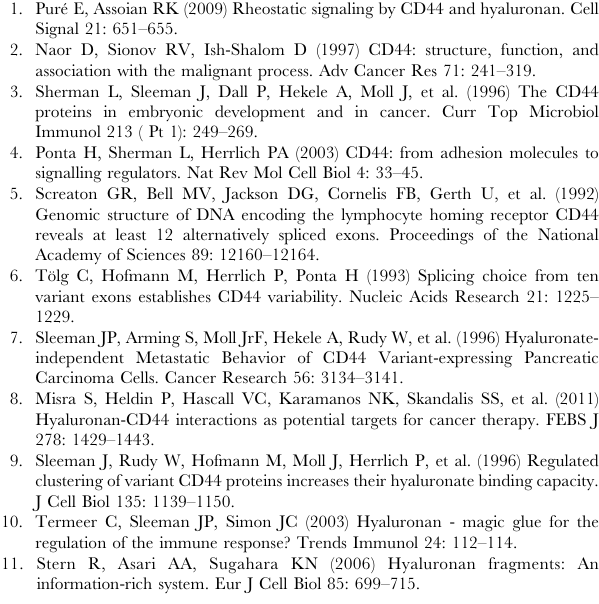
Figure S1 Average area of adhesion. Average area of adhesion after 3 h incubation of 1AS cells, AS-K162R166 cells, ASpSV14 cells, and AS-R44 cells on oligo-HA substrates at , d . , 5.5 nm. More than 50 cells were measured for each cell type and standard deviation is given as error